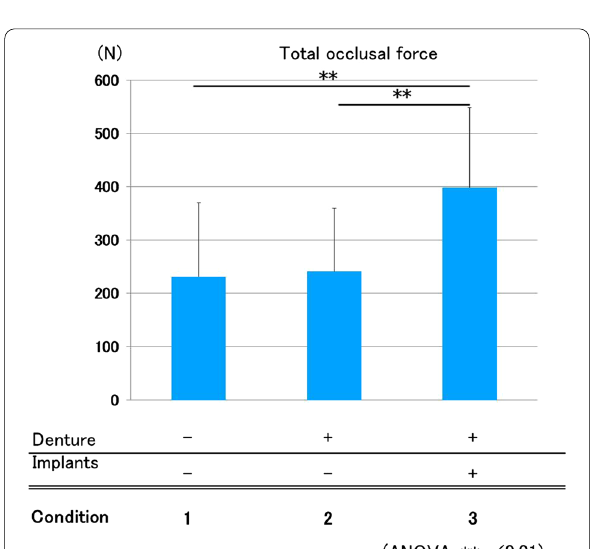
Fig. 3 Total occlusal force. Condition 3 (ISRPD) showed significantly greater total occlusal force than that of others (ANOVA, p < 0.01)